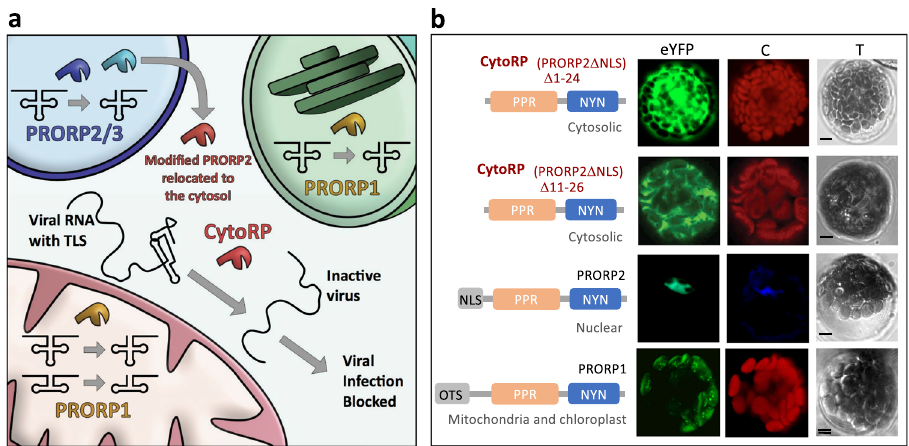
Fig. 1 Strategy to make Arabidopsis cells resistant to viruses containing TLS by directing an RNase P enzyme — referred as CytoRP — to the cytosol. a Principle of the CytoRP technology showing that endogenous plant PRORP enzymes localizations are restricted to mitochondria, chloroplasts, and the nucleus. Because the two PRORP enzymes which are present in Arabidopsis nuclei, have redundant functions 10 , it can be envisaged to relocate one of them (PRORP2) to the cytosol, where virus RNA translation/replication takes place. Nuclear PRORP proteins are shown in blue, organellar PRORP1 in yellow, and the cytosolic CytoRP in red. b CytoRP proteins obtained by two different deletions, i.e. of the fi rst 24 amino acids or of residues 11 – 26, accumulate in the cytosol while PRORP2 and PRORP1 accumulate in the nucleus and organelles, respectively. NLS and OTS show the nuclear localization signal and organellar targeting sequences localized upstream of the functional PPR and NYN domains of PRORP enzymes. The subcellular localization of CytoRP and PRORP protein was analyzed by confocal microscopy of proteins fused to eYFP. Independent observations were performed three times. C indicates the auto fl uorescence of chlorophyll for CytoRP as well as PRORP1 and DAPI staining for PRORP2. T are transmitted light images of Arabidopsis protoplasts transformed with the respective constructs. Scale bars correspond to 5 μ m. Source data underlying b are provided as a Source Data fi